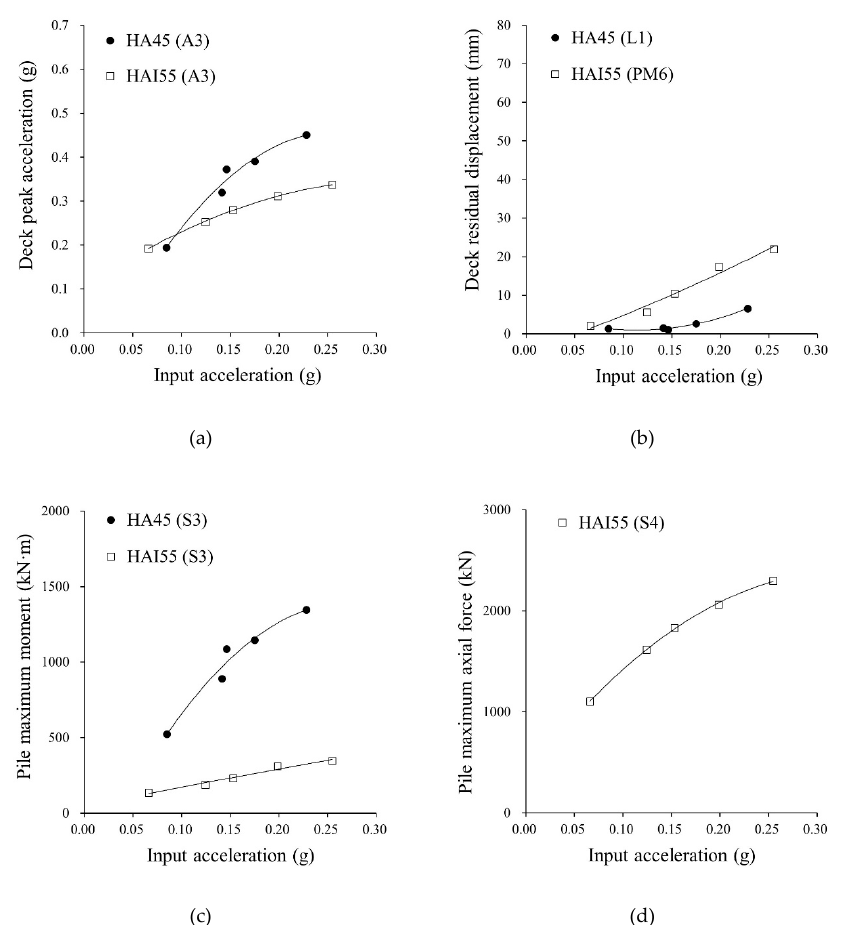
Figure 12. Response of horizontal ground model corresponding to the input acceleration. (scaled to the prototype): ( a ) peak acceleration of deck plate; ( b ) horizontal residual displacement of deck plate; ( c ) maximum moment of vertical pile; and ( d ) maximum axial force of batter pile.